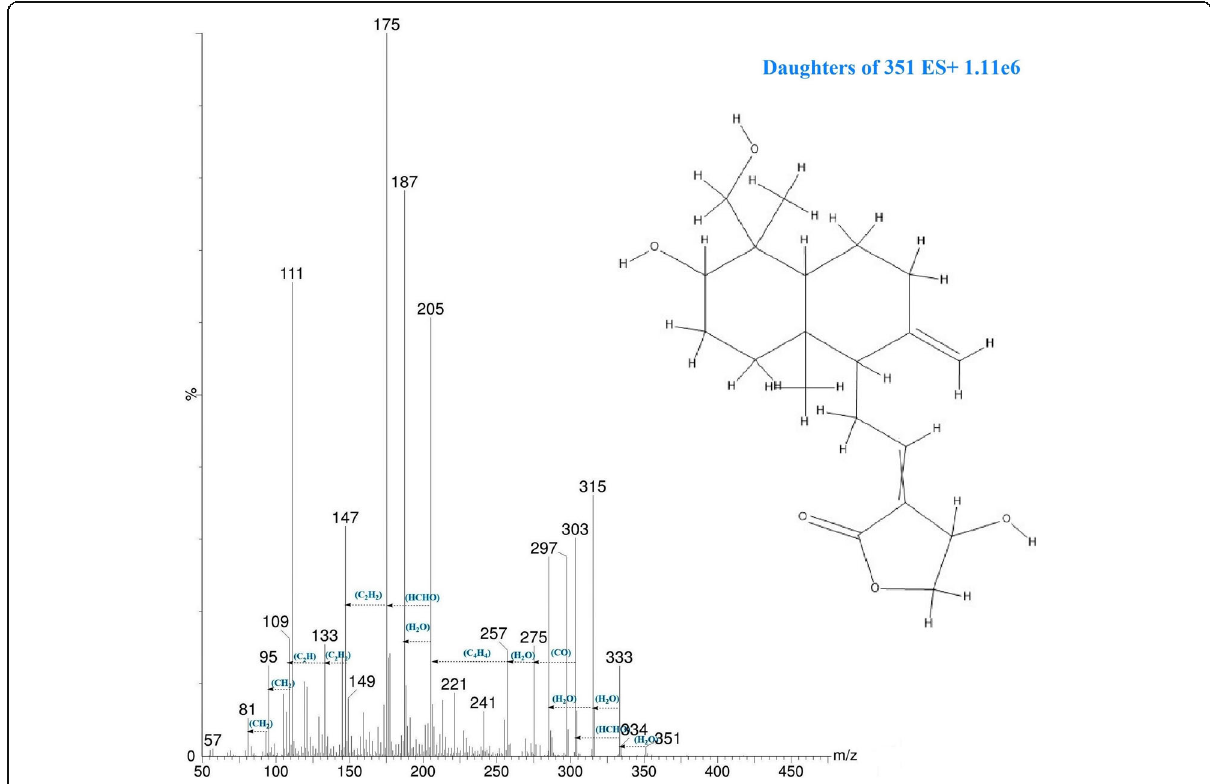
Fig. 9 Fragmentation pathway of Andrographolide